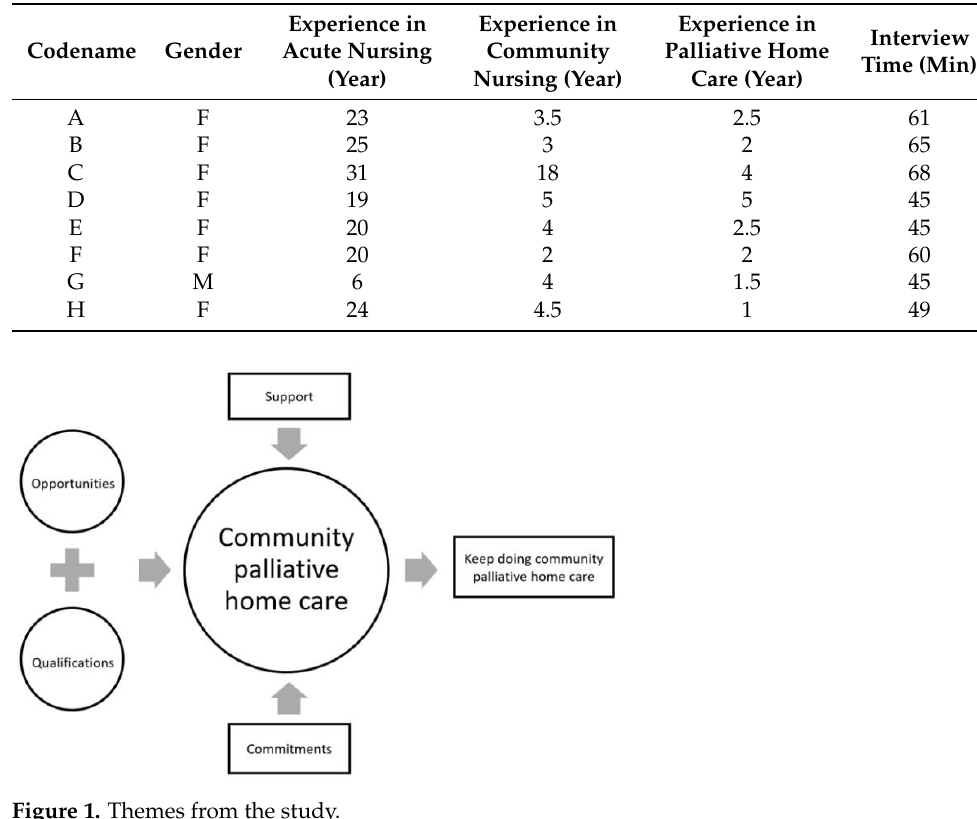
Table 2. Demographic Characteristics of Home Care Nurse Participants.